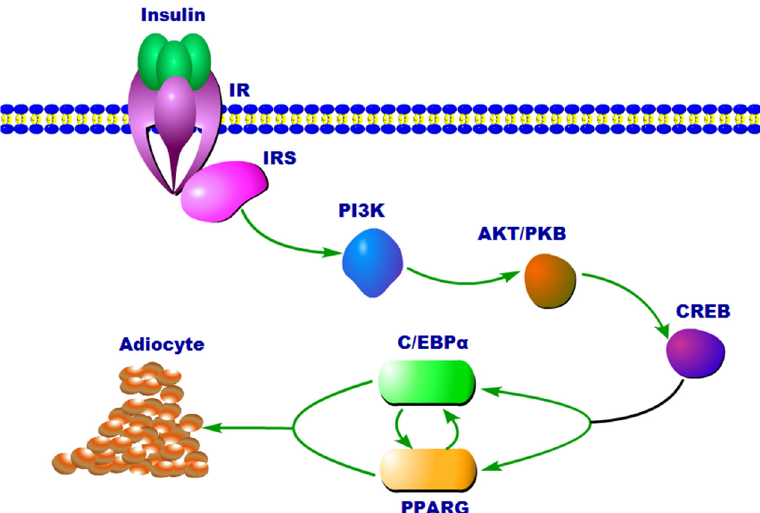
Figure 4. Relationship of adipogenesis signals that directly or indirectly regulate expression that are related to insulin and PPARG (peroxisome proliferator-activated receptor gamma). IR, insulin receptor; IRS, insulin receptor substrate; PI3K, phosphatidylinositol-3 kinase; AKT / PKB, serine / threonine kinase, also known as protein kinase B; CREB, cAMP responsive element binding protein; C / EBP α , CCAAT-enhancer-binding protein α .